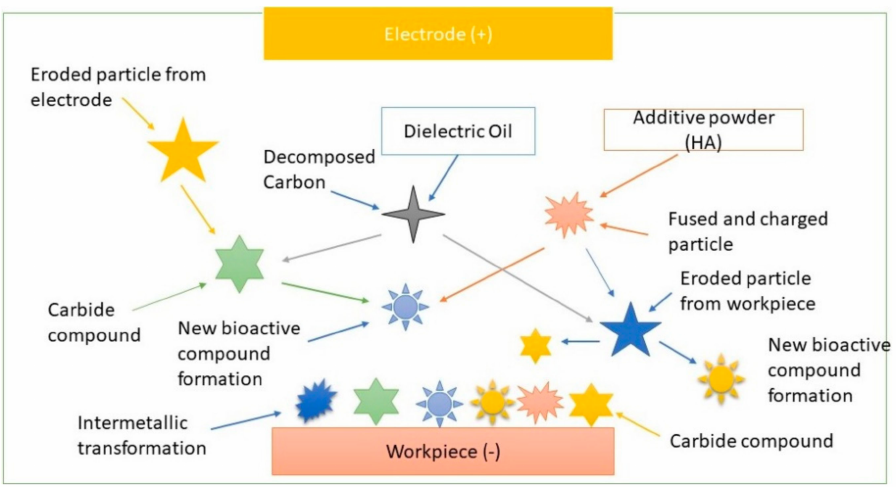
Figure 3. Mechanisms of alloy formation and debris deposition during the powder mixed-EDM (PM-EDM) process reproduced with permission from ref.